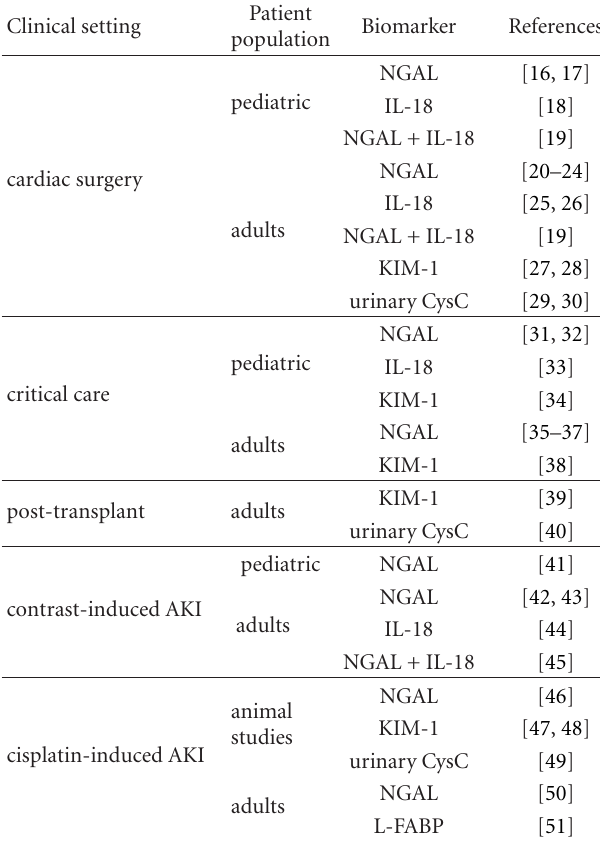
Table 1: Studies of AKI